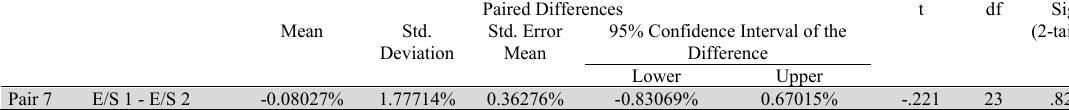
Paired sample T-test SMEs EBIT/Sales